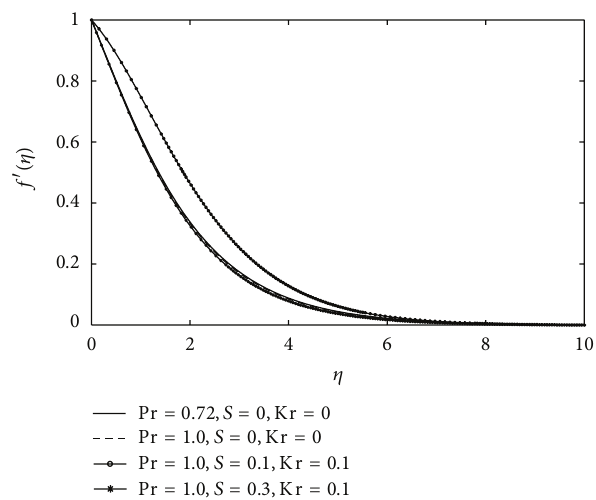
Figure 7: Velocity profiles for different values of Pr, 𝑆 , and Kr for Ha = 0.1 , Gr = 0.1 , Gc = 0.1 , Sc = 0.62 , Bi = 0.1 , and Nc = 0.01 .